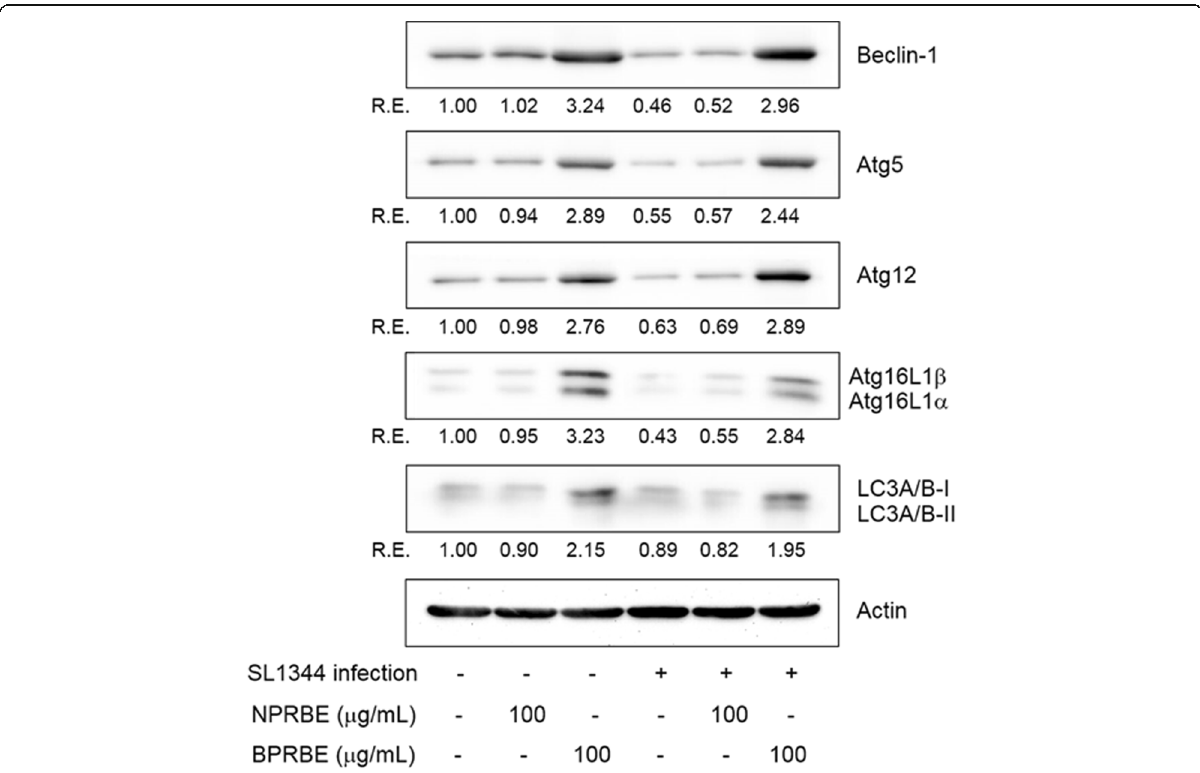
Fig. 4 Effects of BPRBE on induction of Beclin-1, Atg5, Atg12, Atg16L and LC3 in S. Typhimurium-infected macrophages. RAW 264.7 cells were lysed after treatment with BPRBE and NPRBE (100 μ g/mL) for 24 h and infected with S. Typhimurium for 5 h. The cell lysate was subjected to electrophoresis on 12% SDS-PAGE. Western blotting was carried out with the primary antibodies with β -Actin as an internal control. The relative proportions of each protein are expressed as the R. E. (relative expression) values calculated from each target protein/ β -Actin expression. Figures represent results from at least three individual